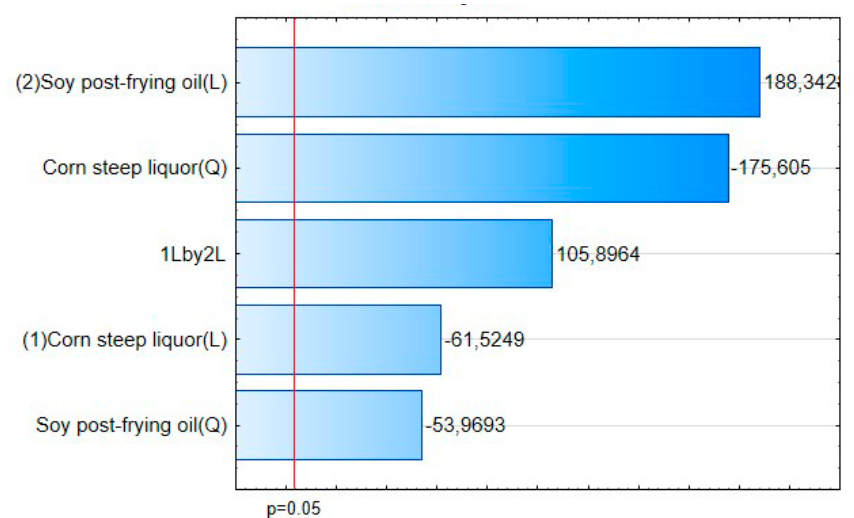
Figure 5. Influence of the independent variables (corn steep liquor and frying residual oil) and their interactions on engine burned oil EA.